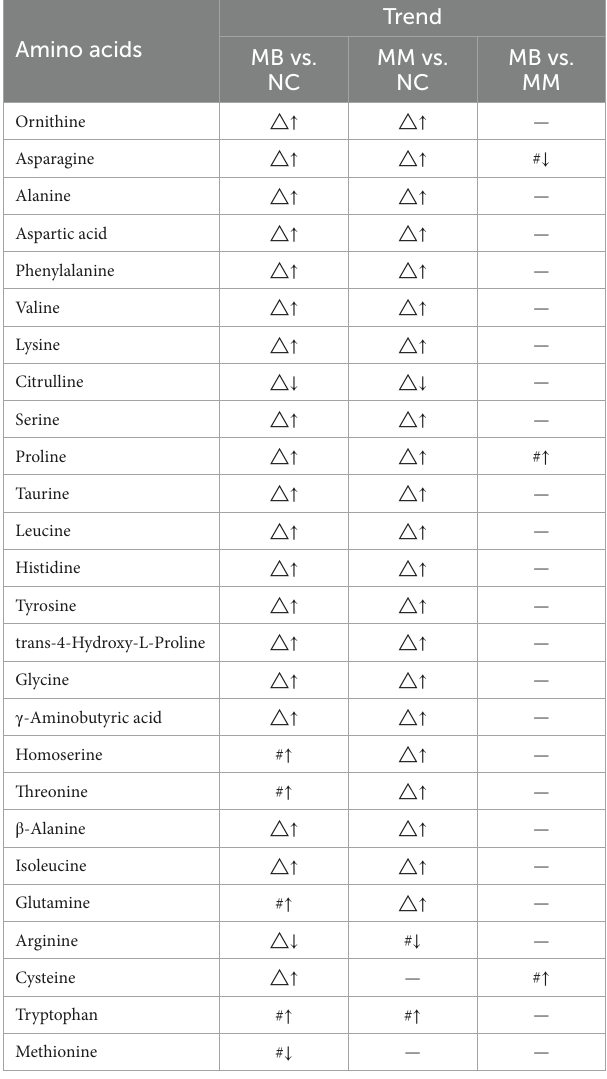
TABLE 3 Significantly altered amino acids in the different groups.